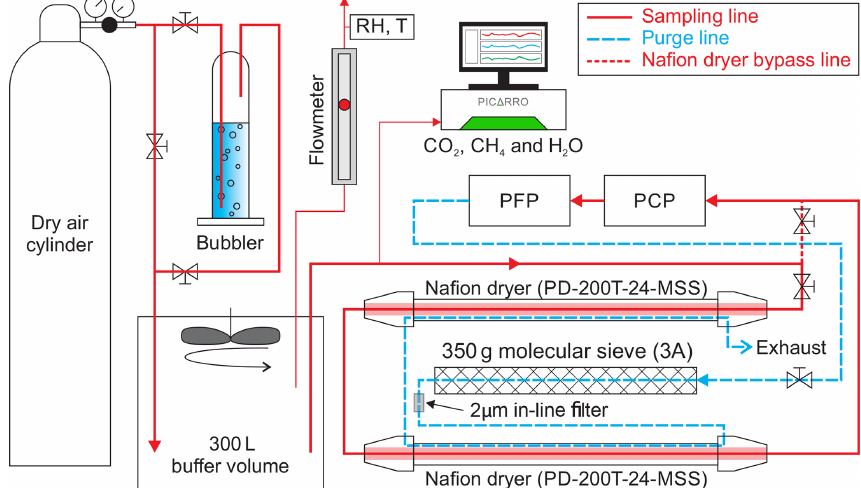
Figure 5. Schematic of the setup used at INSTAAR to determine the effect of the NAD on the mole fraction determination of CO, CH 4 , N 2 O and SF 6 along with CO 2 and its singly substituted isotopologues. A NOAA-ESRL PCP–PFP system could be flushed with either dry or humidified cylinder air including or bypassing the NAD. Flow from the cylinder was adjusted such that there was always an overflow of air from the buffer volume, where relative humidity of the sample was constantly monitored. A Picarro analyzer was used to monitor the stability of CO 2 , CH 4 and H 2 O mole fractions in the gas exiting the buffer volume, during all the tested experimental conditions, a summary of which is shown in Fig. 6. Table 1. Overview of results from Case 1 to Case 5 (test result – reference value) to determine the effect of the NAD on the mole fraction determination of CO 2 , CO, CH 4 , N 2 O, CO, and SF 6 , as well as on the isotopic composition of the two singly substituted isotopologues 16 O 13 C 16 O and 16 O 12 C 18 O of CO 2 . The measurement uncertainty denotes the 1 σ standard deviation of typically three samples per condi- tion. Species Case 1 Case 2 Case 3 Case 4 Case 5 dry air, with wet air, without wet air, with wet air, with wet air, with dryer – dry air, dryer – dry air, dryer – dry air, dryer – wet air, dryer – dry air, without dryer without dryer without dryer without dryer with dryer CO 2 (ppm) − 0 . 02 ± 0 .